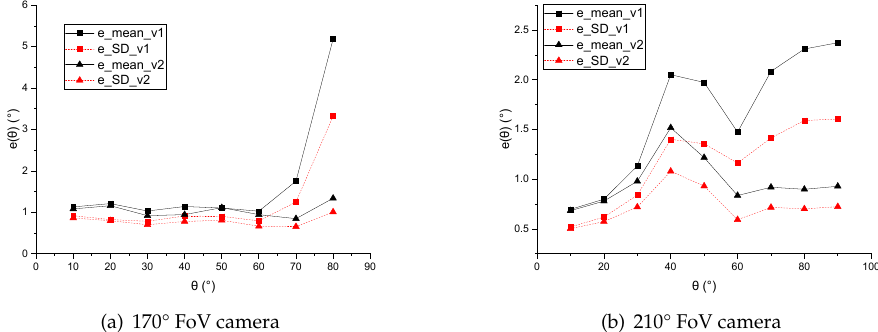
Figure 10. e − θ curves of two versions of feature point direction calculation methods in 170° FoV camera and 210° FoV